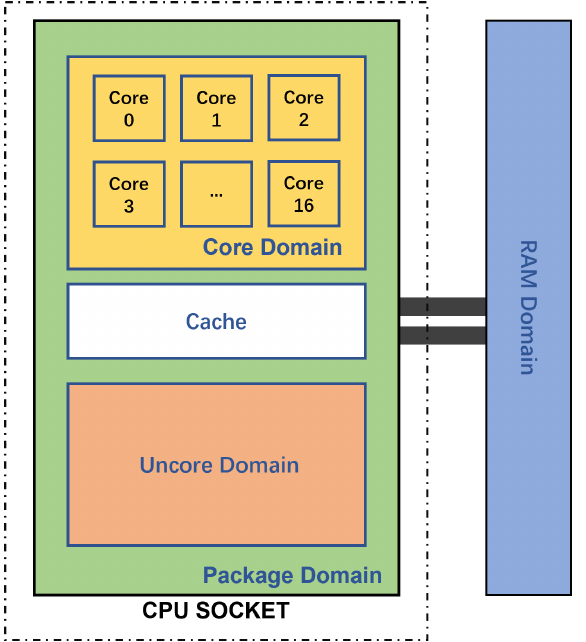
Figure 9. RAPL domain match part of our CPU socket. The energy consumption of the core measured by pyJoules is the sum of the CPU core energy consumption, the energy consumption of the packages is the wall CPU energy consumption, and the energy consumption of the uncore is the energy consumption of the integrated GPU.